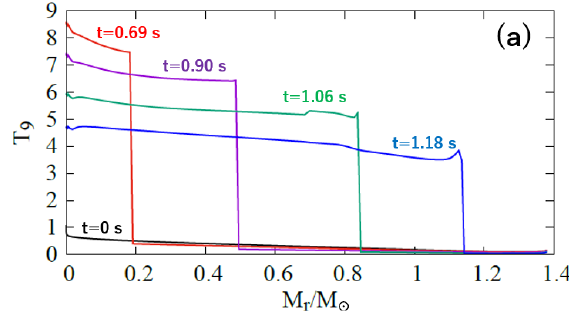
Figure 1. The temperature profile in the W7 model